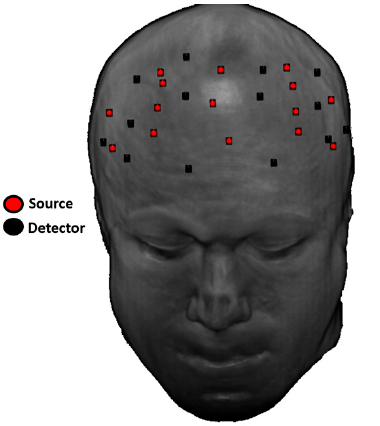
Figure 1. Illustration of the source-detector ( SD ) positions co-registered onto a structural magnetic resonance imaging ( MRI ) template.